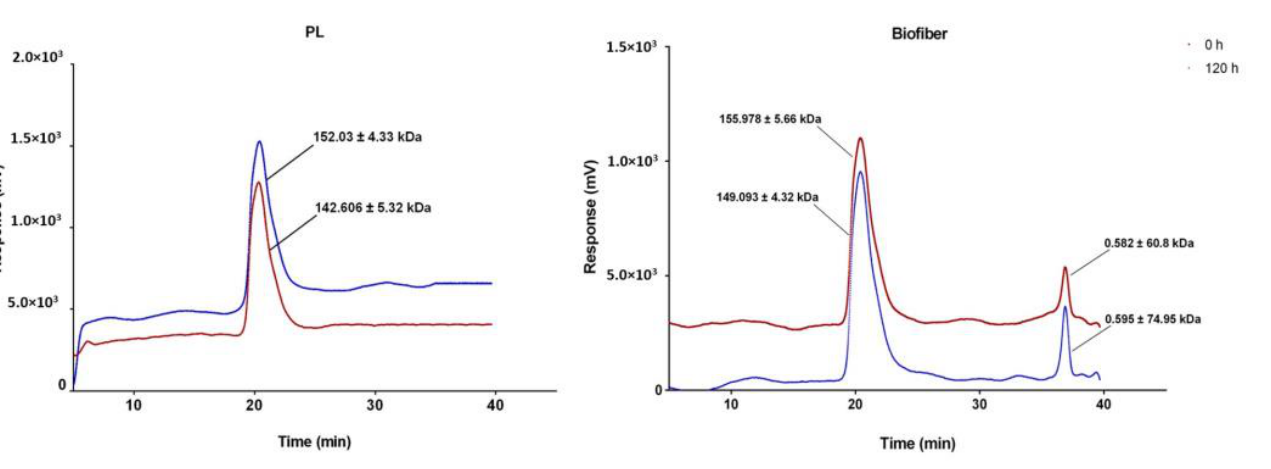
Figure 8. Chromatograms of placebo (PL) and Biofiber prototypes obtained through GPC analysis using isocratic grade THF at 0.8 mL/min as mobile phase. Red chromatogram (0 h) represents dry sample; blue signal (120 h) is referred to prototypes after 120 h of incubation in SWF at 34 °C, RH Ambient. Black lines indicate the respective molecular weight of PLA-PCL and NG before and after 120 h of incubation in SWF.